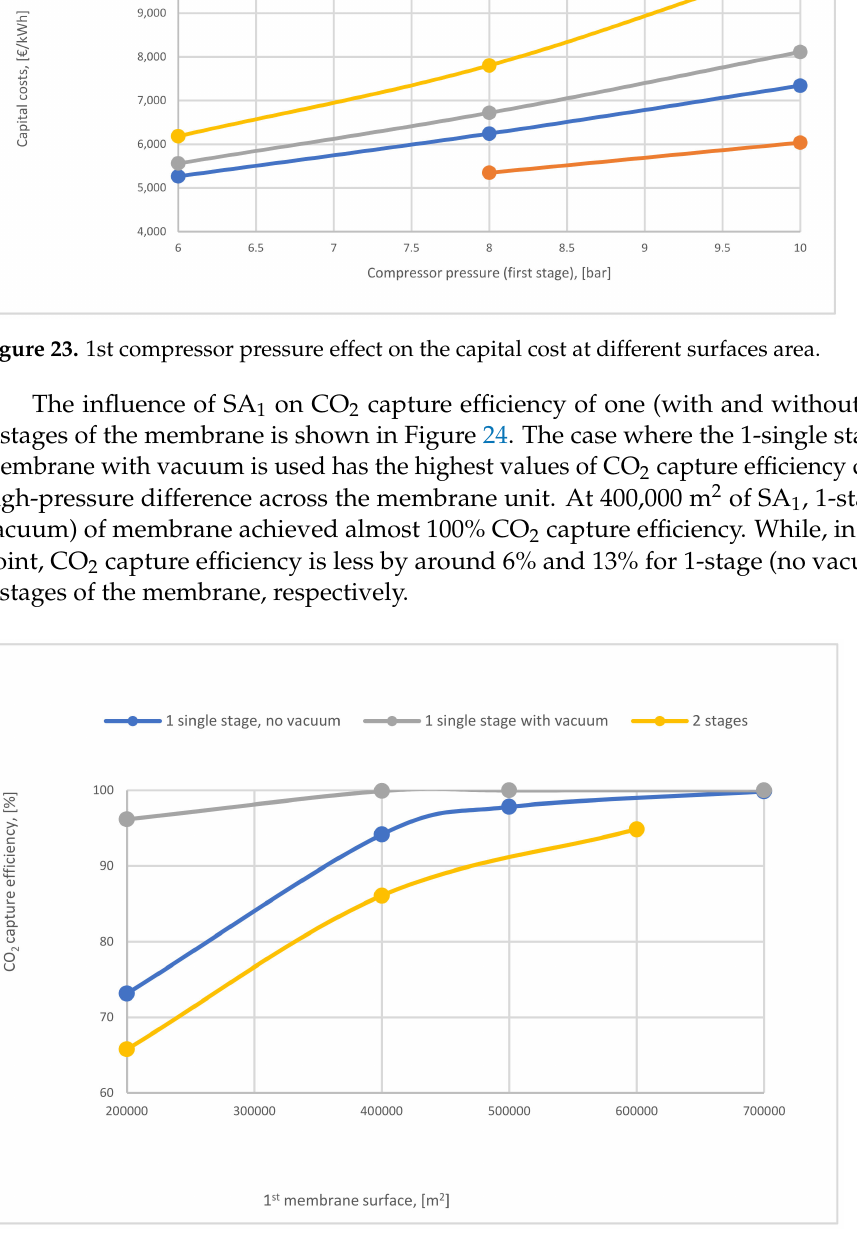
Figure 24. The impact of 1st membrane surface on CO 2 capture efficiency of 1 and 2-stages of membrane at 8 bar CP 1 , 4 bar CP 2 , and 40,000 m 2 of SA 2